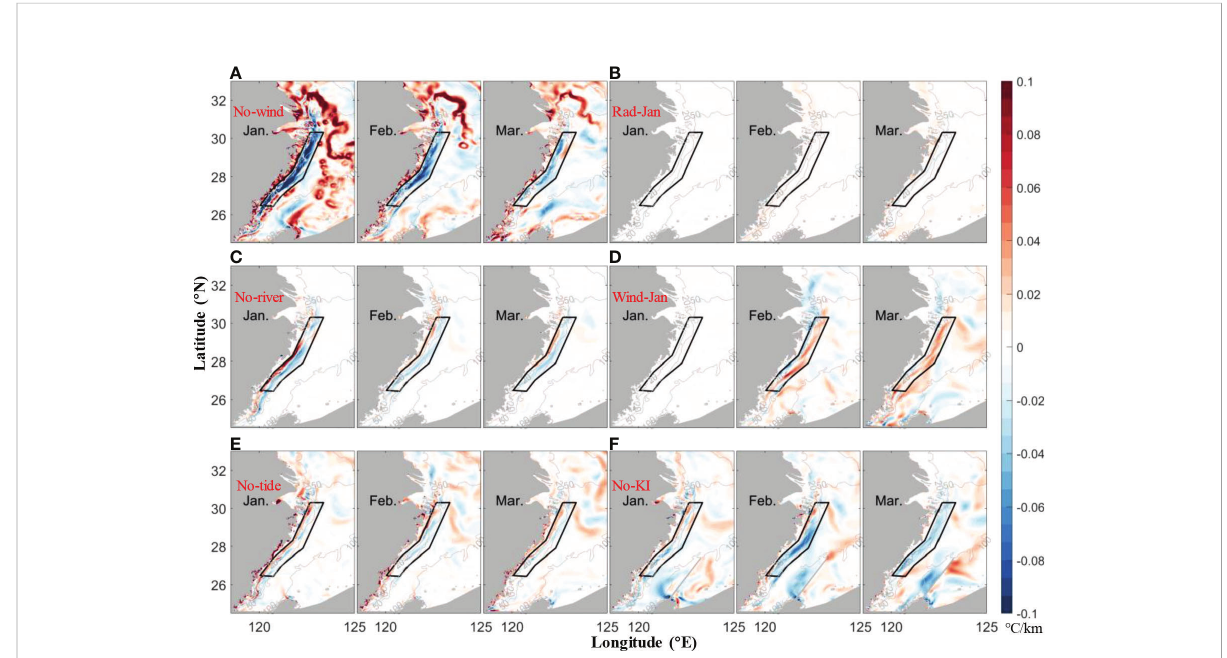
FIGURE 13 Differences in SST gradient between six sensitive experiments and the control run (A – F) . The focus region is marked off with a black